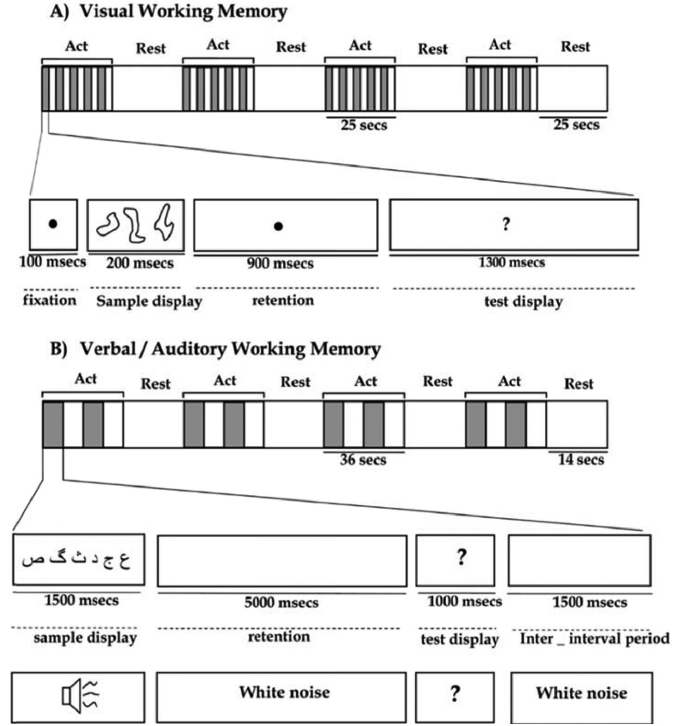
Fig. 1. An illustration to present task design. A: visual working memory. B: verbal and auditory working memory tasks. Question marks mean “decision time” for the